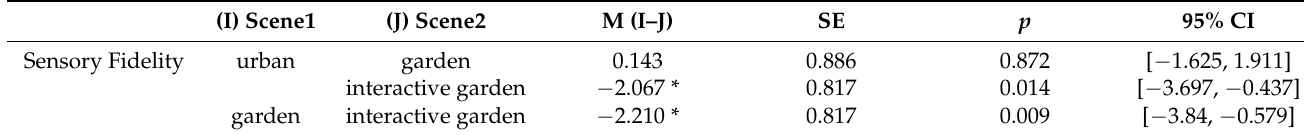
Table A1. Post-test results.